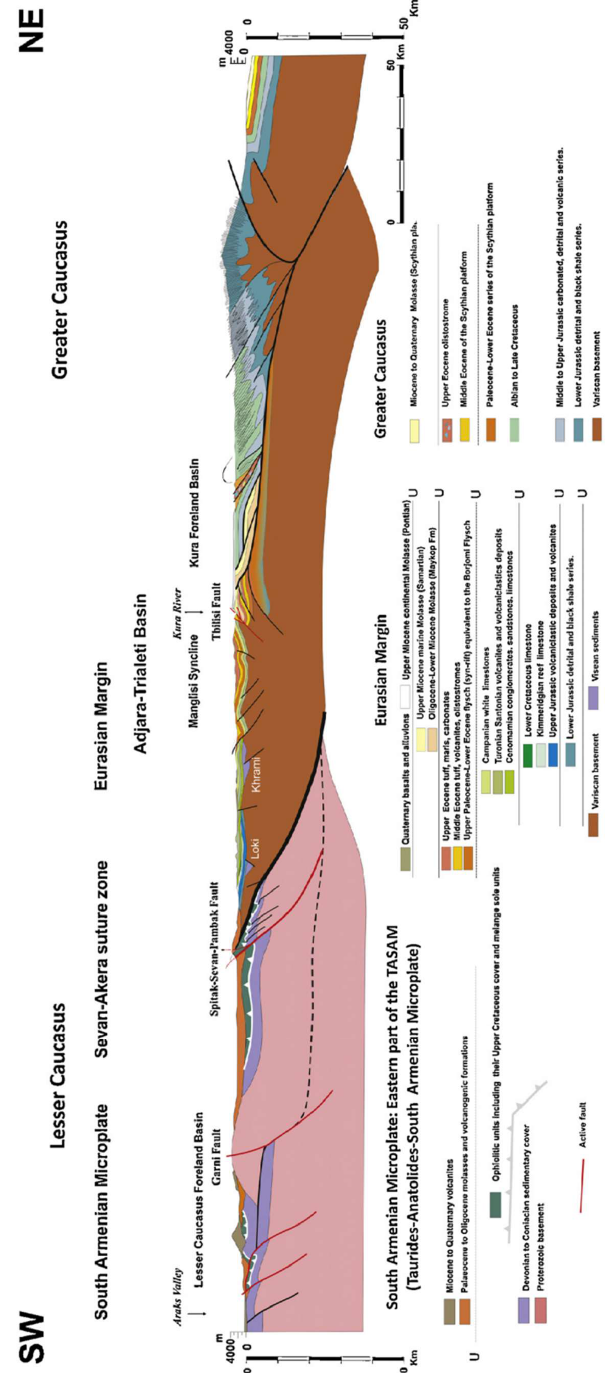
Figure A1. Geological section of the Black Sea Caucasus region (along red line shown in the geological map in Figure 1, modified after [7,8]).